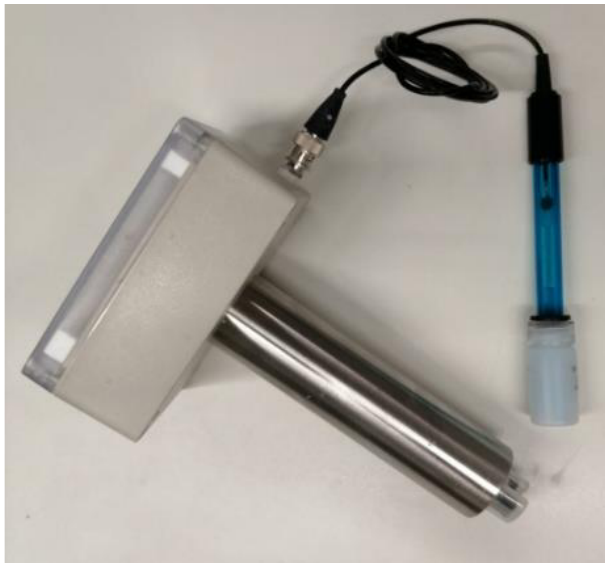
Fig. 3. Prototype with measurement technology for production monitoring,